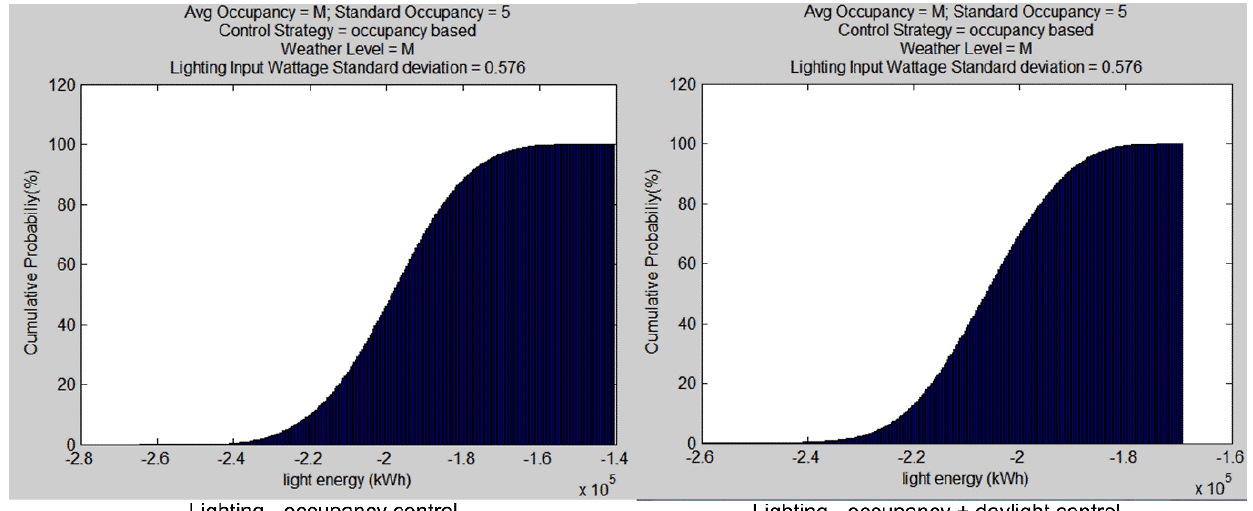
Figure 9. CDFs of lighting energy difference between retrofit and existing lighting